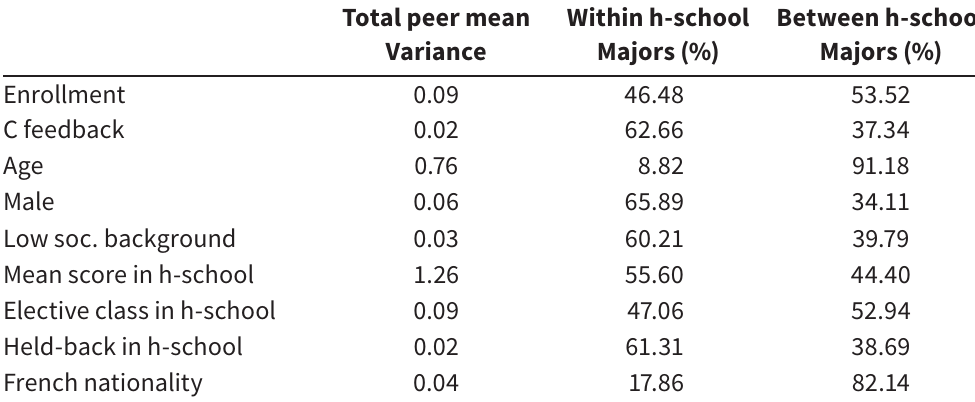
Table A1 Decomposition of the variance in peer group-level